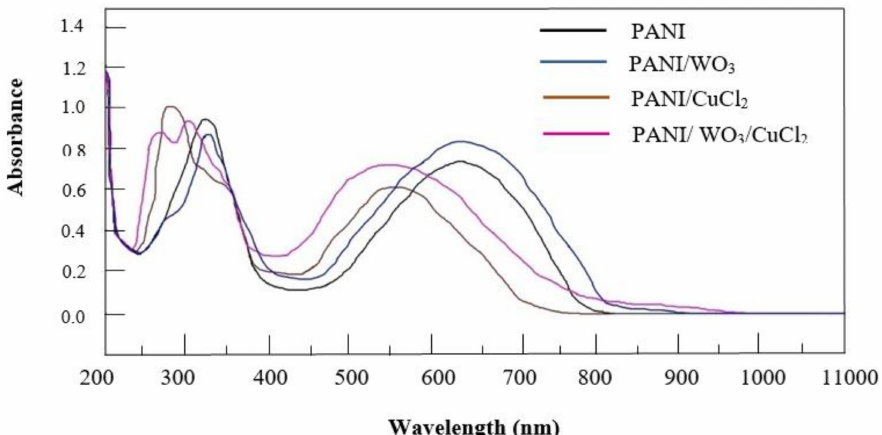
Figure 25. Ultraviolet visible spectra of components present in PANI/WO 3 /CuCl 2 composites to analyze their chemical conversion in NMP (N-methyl-2-pyrrolidone)